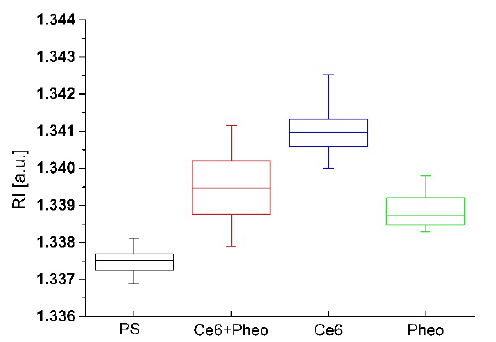
Figure 7. The changes of RI values of cells with accumulated photosensitizer and without PS after 48 h incubation in the case of non-irradiated samples.